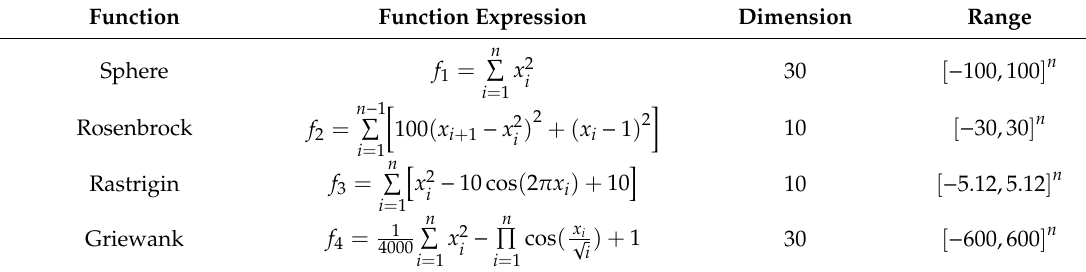
Table 1. Related information of four functions.